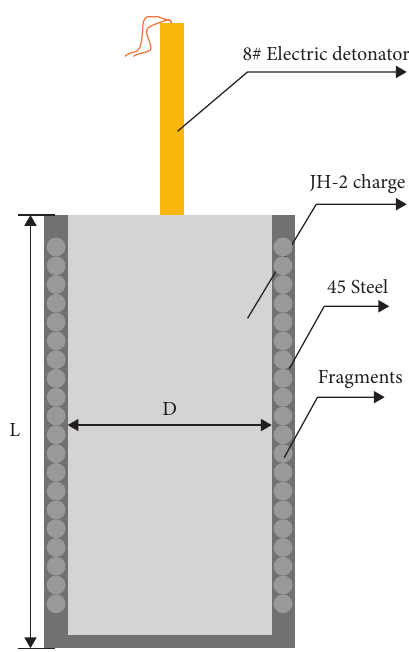
Figure 3: Schematic diagram of the sample structure.